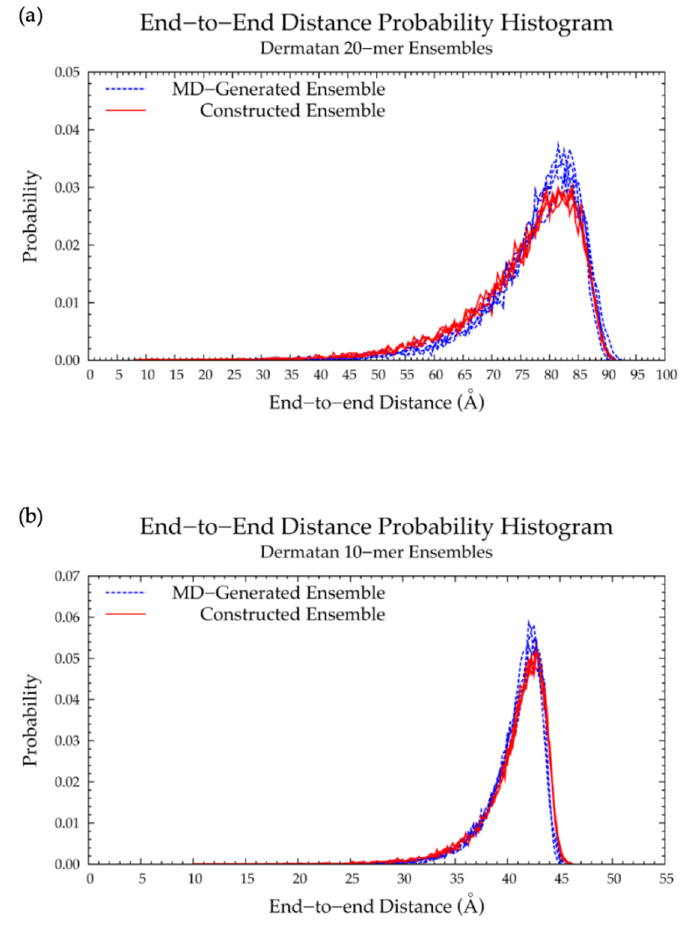
Figure 12. End-to-end distance probability distributions of MD-generated (blue dashed lines) and constructed (red solid lines) nonsulfated dermatan ensembles: ( a ) 20-mer and ( b ) 10-mer; probabilities were calculated for end-to-end distances sorted into 0.5 Å bins for the 20-mer and 0.25 Å bins for the 10-mer; each ensemble includes four sets of 10,000 conformations.